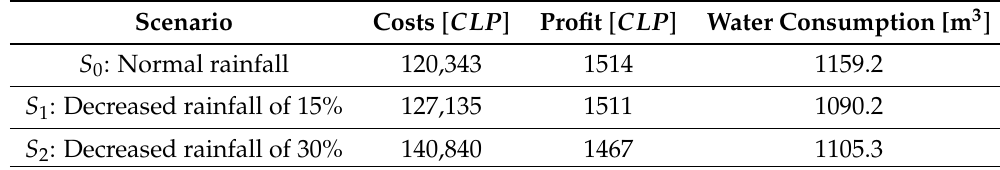
Table 3. EWMS results using the baseline and reduced rainfall